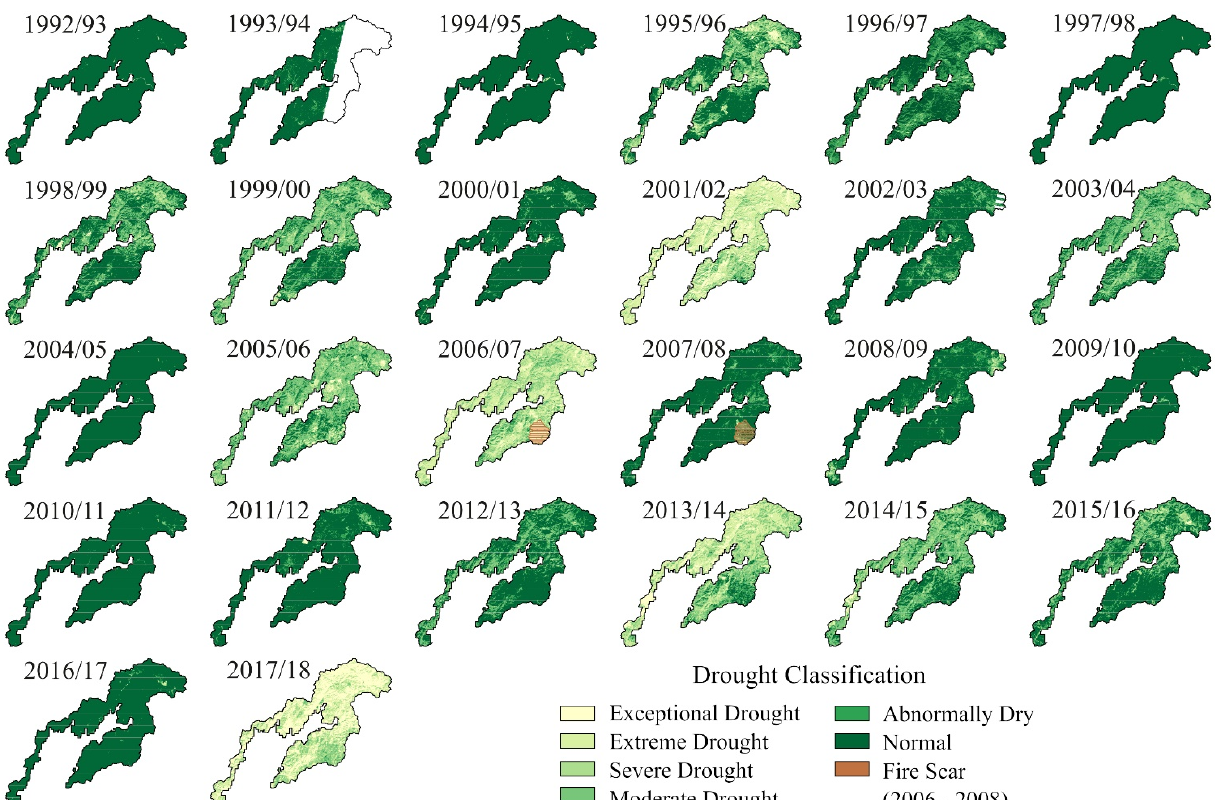
Figure 6. Spatial distribution of Modified Soil Adjusted Vegetation Index standardized predicted values in the intervening season 2 (IS2) to classify annual drought severity and spatial extent from 1992/93 to 2017/18 hydrological years at the Guadalupe Valley Basin, Baja California, Mexico. During the 1993/94 hydrological year, there was a missed area due to incomplete Landsat 5 TM scene data.